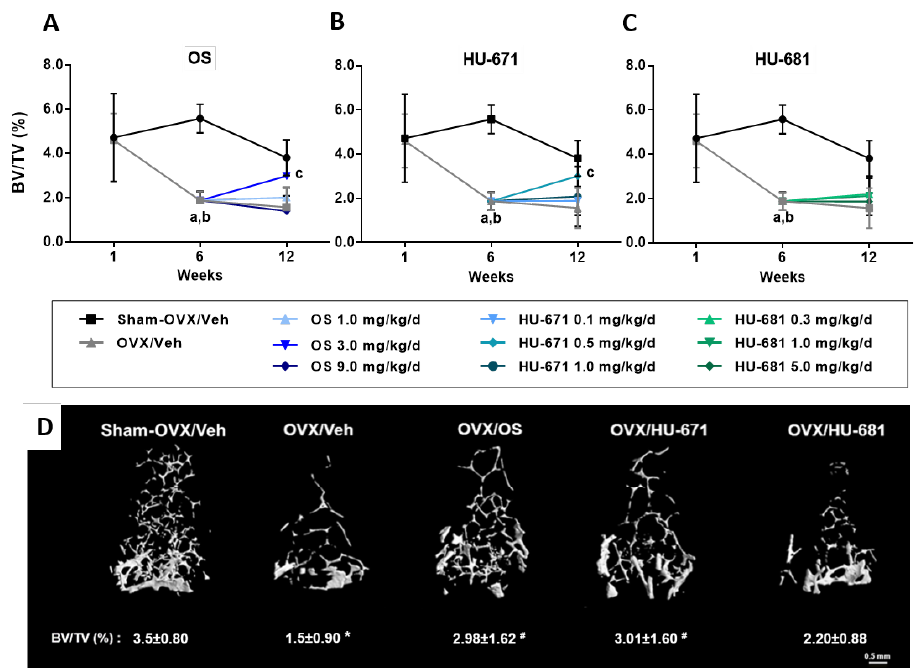
Figure 2. Assessment of trabecular bone volume density in the distal femoral metaphysis of ovariectomized (OVXed) mice treated with OS and its methylated derivatives. The trabecular bone volume density (BV/TV) of distal femoral metaphysis after treatment with OS ( A ), HU-671 ( B ), or HU-681 ( C ). Representative 3D images of the distal femoral metaphysis of mice with median BV/TV values for each treatment ( D ). Data represent the means ± SDs obtained from 7 – 9 mice per condition. a p < 0.05 versus the 1-week OVX/Veh-treated group, b p < 0.05 versus the 6-week Sham-OVX/Veh-treated group, c p <0.05 versus the 12-week OVX/Veh-treated group, * p < 0.05 versus the Sham-OVX/Veh-treated group, # p < 0.05 versus the OVX/Veh-treated group.